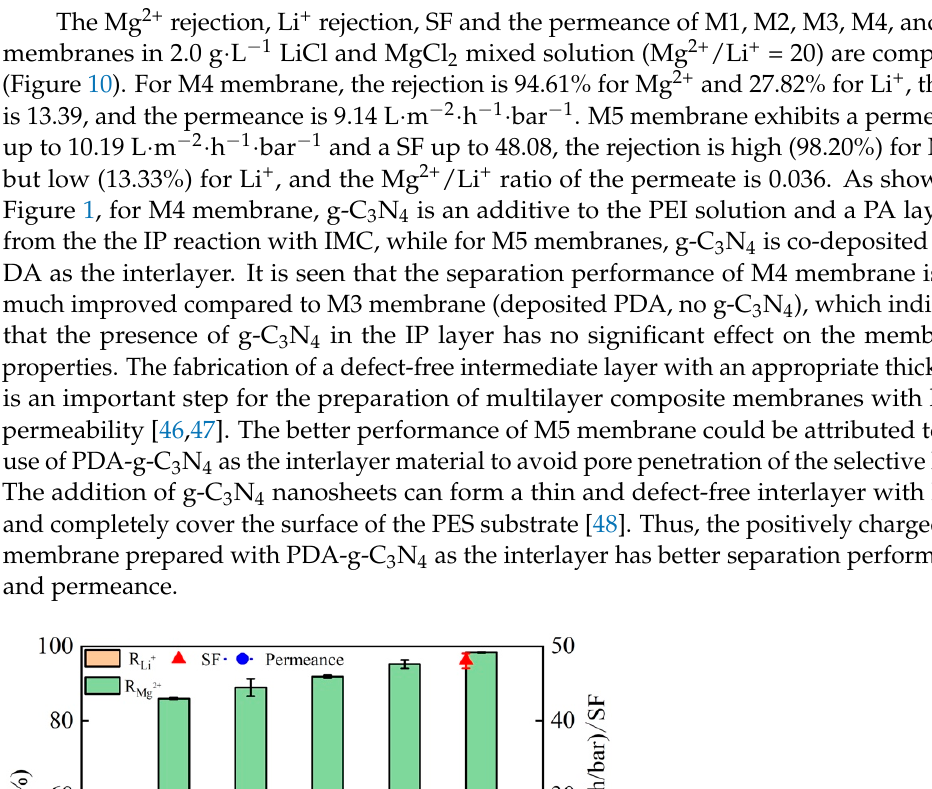
Figure 9. Effect of the stripping time of g-C 3 N 4 on the separation performance and permeance. The Mg 2+ rejection, Li + rejection, SF and the permeance of M1, M2, M3, M4, and M5 ure 10). For M4 membrane, the rejection is 94.61% for Mg 2+ and 27.82% for Li + , the SF is 13.39, and the permeance is 9.14 L·m − 2 ·h − 1 ·bar − 1 . M5 membrane exhibits a permeance up to